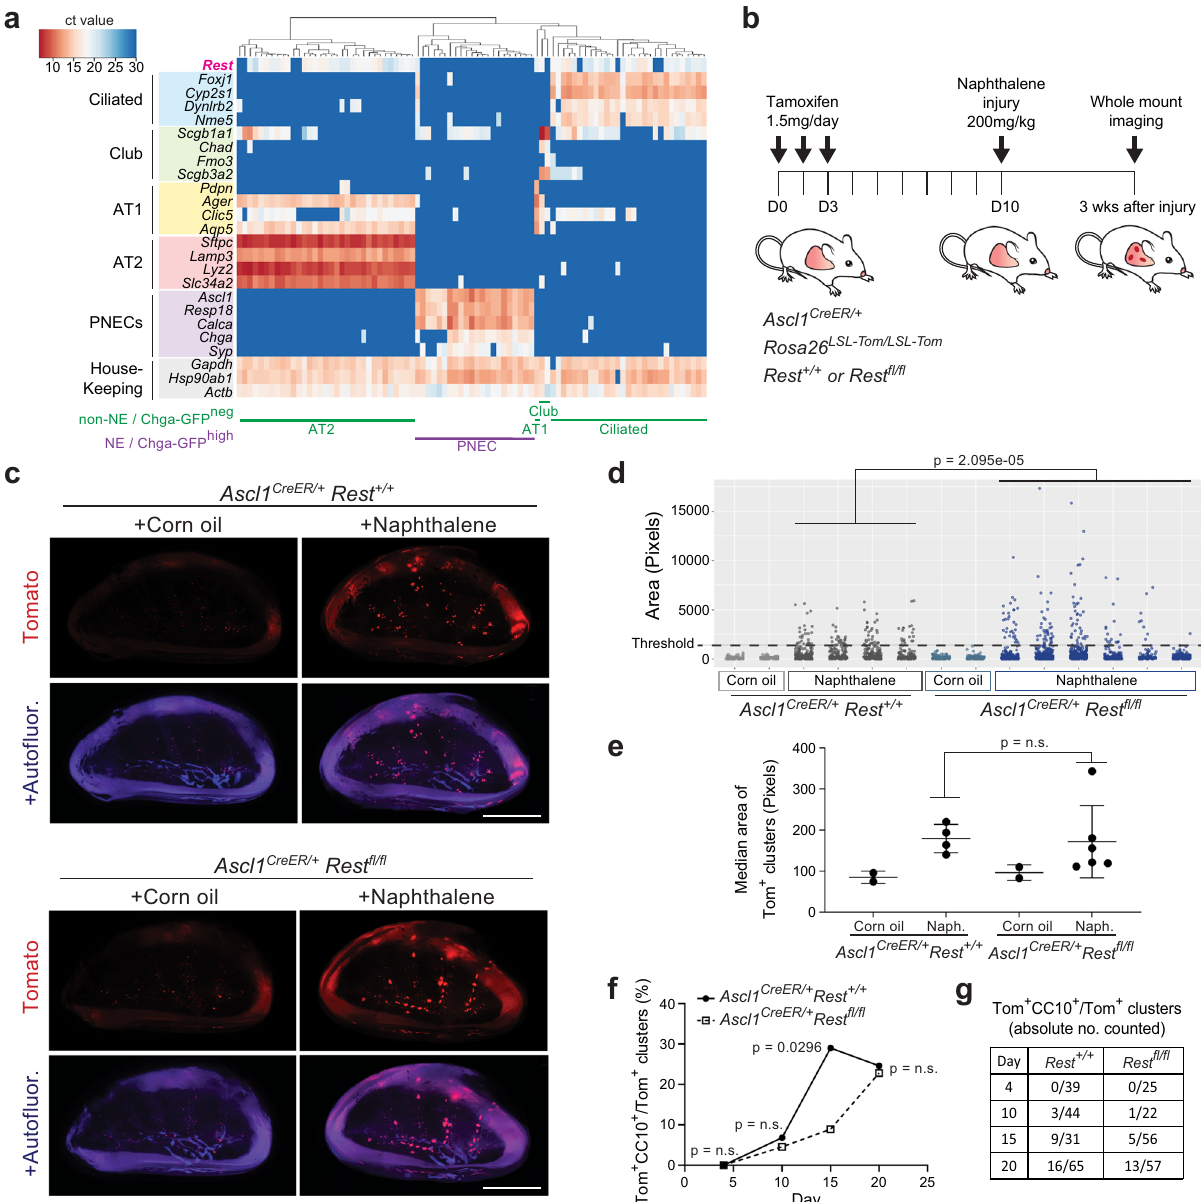
Fig. 4 Loss of REST delays pulmonary neuroendocrine cell fate transition in response to naphthalene injury. a Single-cell RT-qPCR analysis of Rest expression in pulmonary neuroendocrine cells (PNECs) and non-NE lung epithelial cells from normal lungs of two Chga-GFP adult mice ( n = 87 cells). b Timeline of the PNEC lineage tracing and naphthalene-induced lung injury experiment. Tom, Tomato fl uorescent reporter. c Whole-mount fl uorescence images of left lung lobes 3 weeks after injury. Images representative of n = 2 independent experiments. Scale bar, 5 mm. d , e Quanti fi cation ( d ) of normal neuroepithelial bodies (NEBs) and PNEC outgrowths after injury as in ( c ) with each column representing a single mouse left lung lobe and each data point a tomato-positive cluster in that mouse. A Wilcoxon rank sum test, two-sided, was conducted on the combined PNEC outgrowths from all the mice in each respective group that are above the threshold size of the non-injured controls ( n = 107 for Rest + / + , n = 146 for Rest fl / fl ). Median area ( e ) of all Tom + clusters per mouse as in ( d ) ( n = 2 mice for corn oil controls, 4 mice for naphthalene-treated Ascl1 CreER/ + ; Rest + / + and 6 mice for naphthalene-treated Ascl1 CreER/ + ; Rest fl / fl ). Unpaired t -test, data represented as mean ± s.d. f , g Percentage ( f ) and absolute number counted ( g ) of Tom + CC10 + clusters over total number of Tom + clusters at various timepoints after naphthalene injury ( n = number of clusters as indicated in table ( g ) totaled from representative left lung lobe sections of 3 – 4 mice per timepoint). Fisher ’ s exact test, two-tailed. See also Supplementary Fig. 7. Source data are provided as a Source Data fi